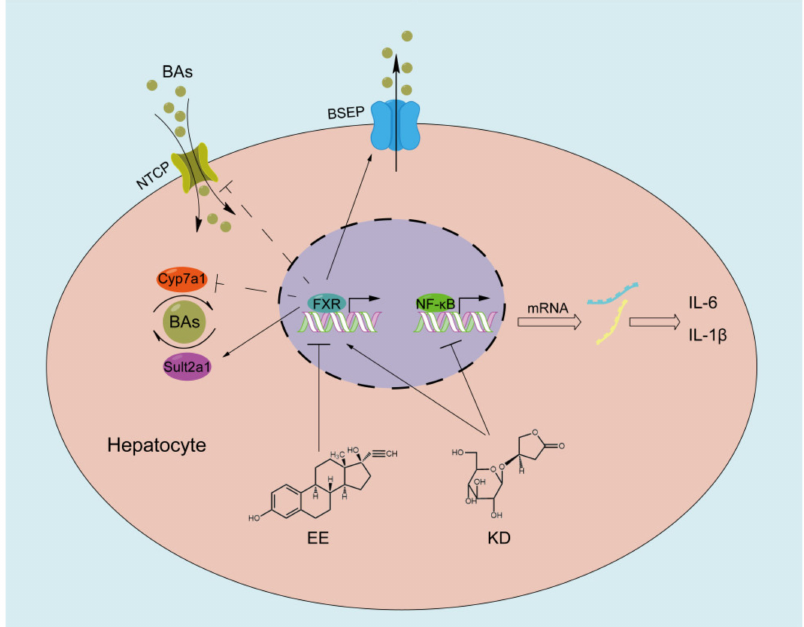
Figure 7. Schematic diagram of potential working mechanisms that KD alleviates EE-induced cholestatic liver